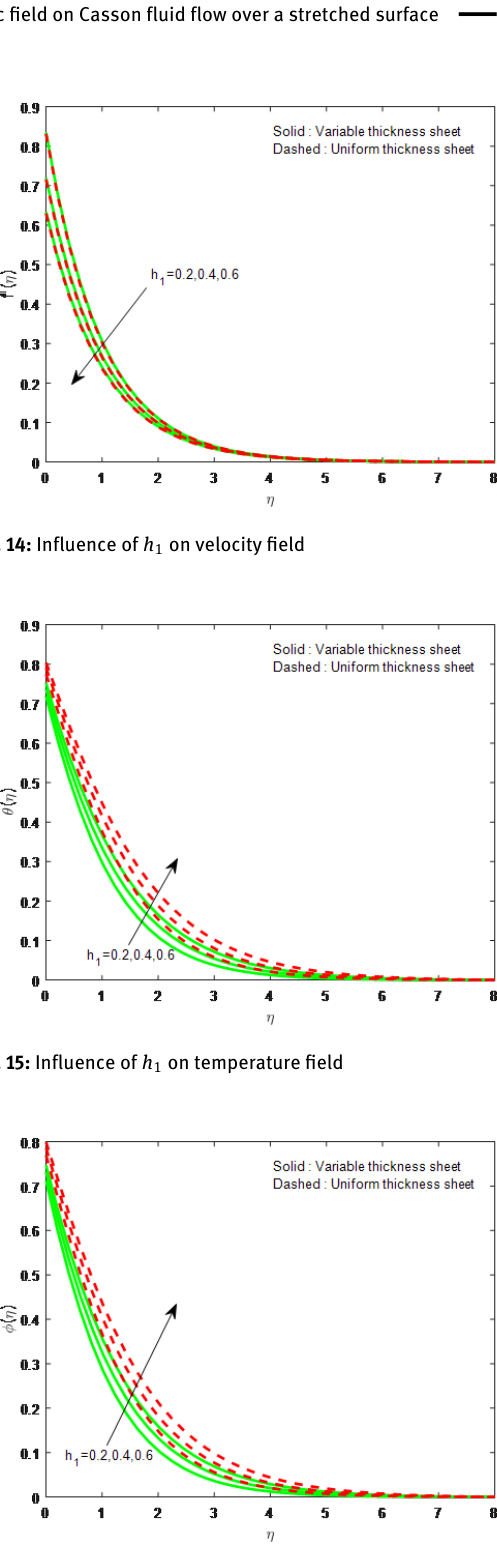
Fig. 16: Influence of h 1 on concentration